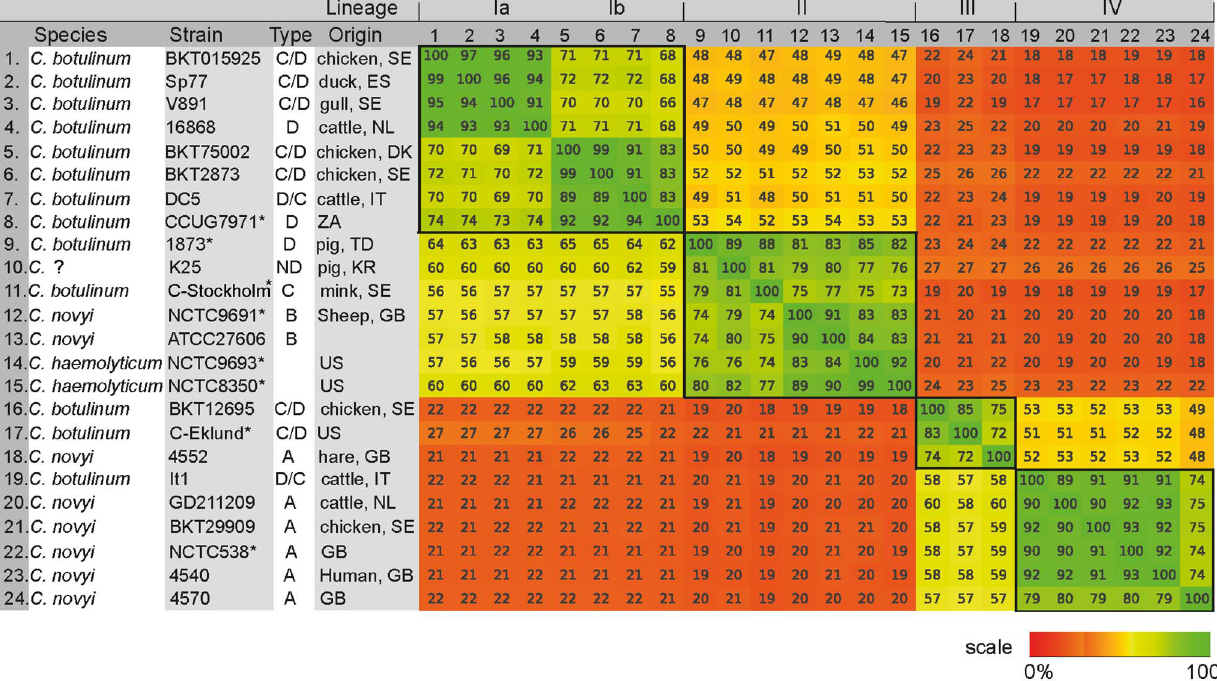
Figure 1. Average whole genome similarity of C.novyisensulato genomes. A similarity matrix based on normalized average BLASTN sores for fragmented comparisons covering the whole genomes (200 bp fragment size) illustrated by a heat-plot. Four lineages were identified (I–IV) and are framed with black squares. The geographical origins of the strains are listed with two-digit country codes. Strains isolated more than 50 years ago are marked with a star.